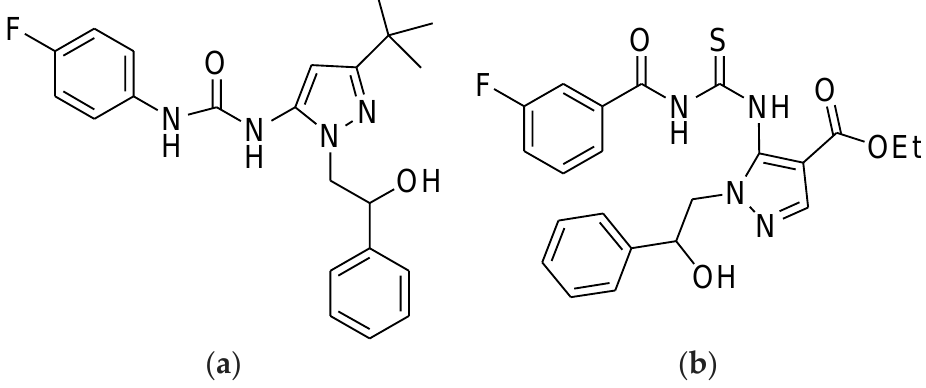
Figure 1. Chemical structure of the previously reported antibacterial pyrazoles 3c ( a ) and 4b ( b ). Particularly, 3c was active against different strains of vancomycin resistant (VRE) ente- rococci ( E. faecium and E. faecalis ), methicillin resistant S. aureus (MRSA), and S. epidermidis (MRSE), while 4b exhibited antibacterial effects specifically against staphylococci. More- over, the data reported established that both compounds can be promising for the develop- ment of new antibacterial formulations to specifically counteract infections sustained by staphylococci, against which both ciprofloxacin and most beta-lactam drugs are no longer active. Additionally, compound 3c can also be useful against enterococci isolates, which is difficult to inhibit with ampicillin [14]. Here, to develop topical antibacterial formula- tions based on 3c and 4b , we formulated them as hydrogels, considering that among the bactericidal/antibacterial devices, those formulated as hydrogels could effectively satisfy the urgent demand for new and successful antibacterial formulations suitable for topical administration